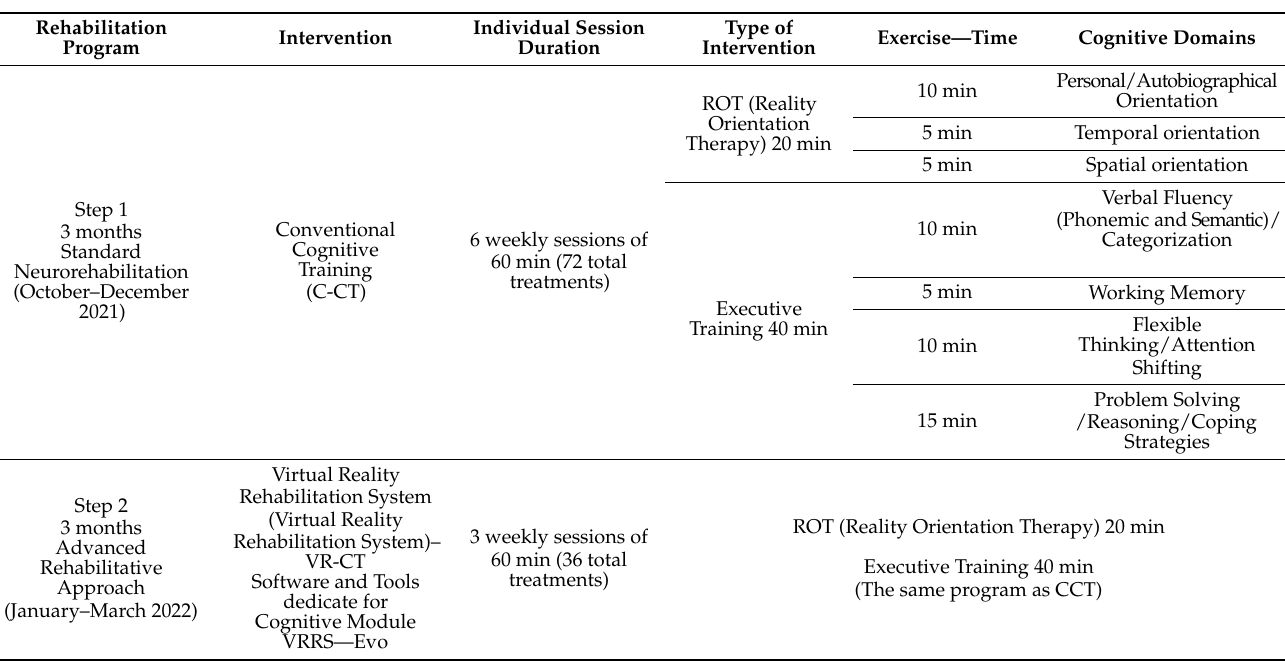
Table 2. Cognitive Training focused on visuo-executive abilities: individual session, duration and type of